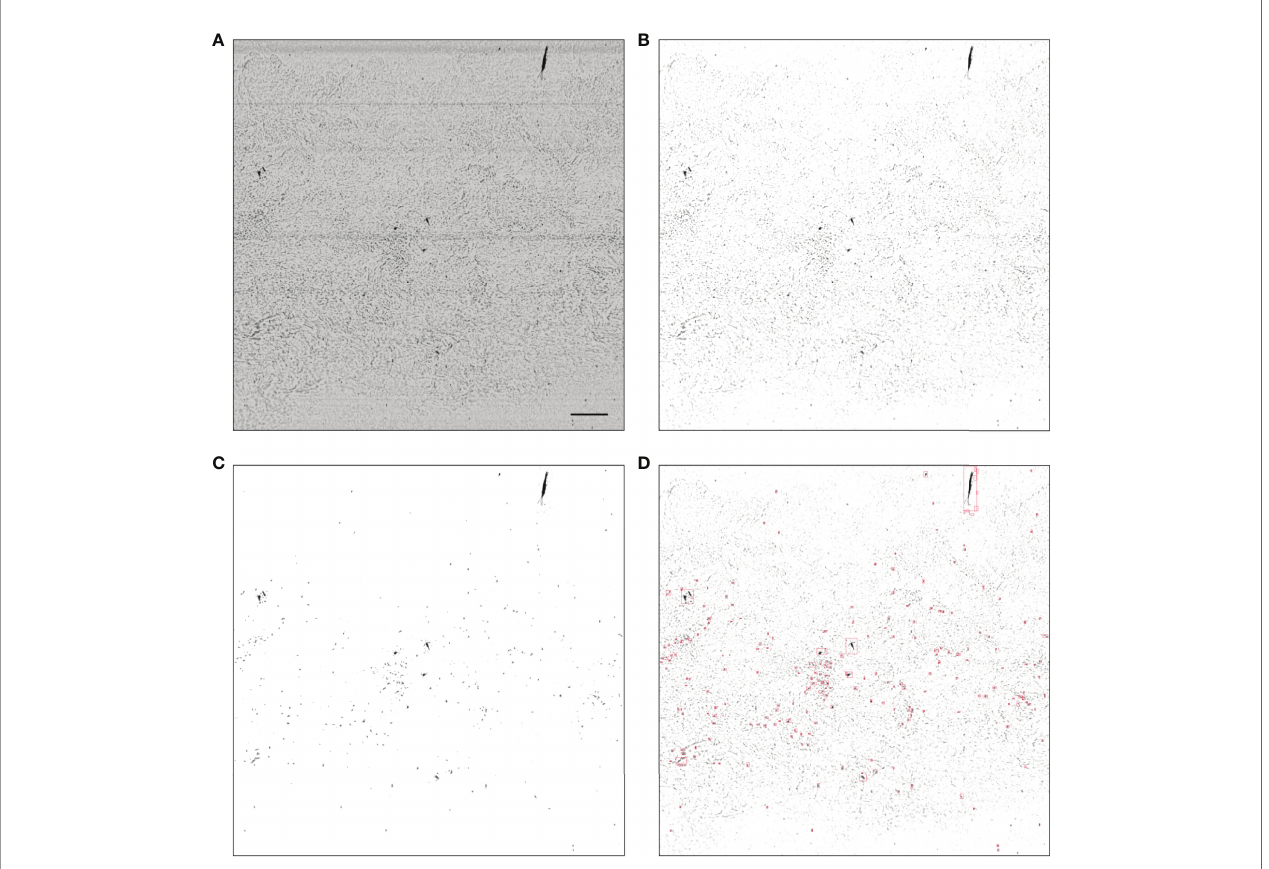
FIGURE 2 | Example MSER segmentation of a noisy raw frame (with low SNR). (A) Raw output; (B) after fl at- fi elding; ( C) regions of interest created through naive thresholding; (D) regions of interest and their bounding boxes created by applying MSER to (C) . In a low SNR frame such as the one above the processing steps are (A – D) , while in a high SNR frame the processing steps are (A, B, D) . In panel (A) , the scale bar represents 1 cm and is applicable to other